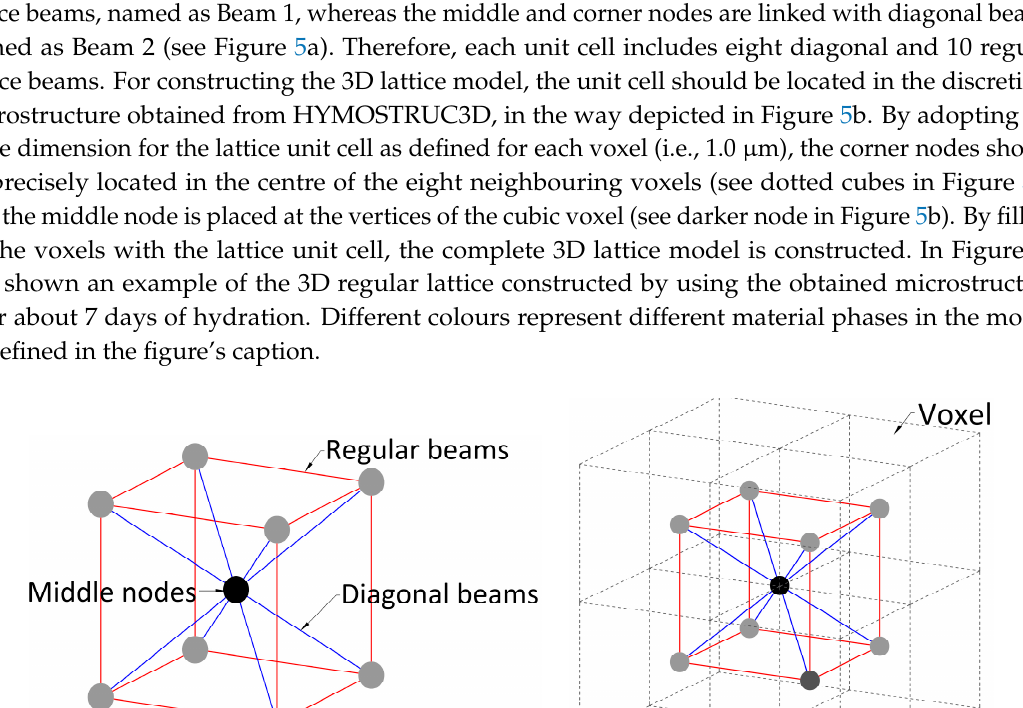
Figure 6. ( a ) 3D regular lattice model, ( b ) FE model—grey: unreacted cement, red: C-S-H inner, yellow: C-S-H outer, green: CH, black: all interface beams, blue: pore phases.